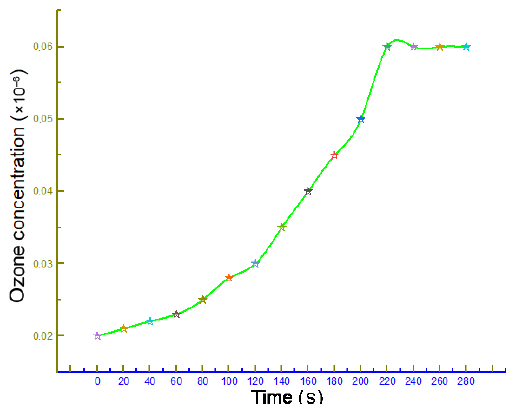
Fig. 5 Experimental result of ozone concentration in air.